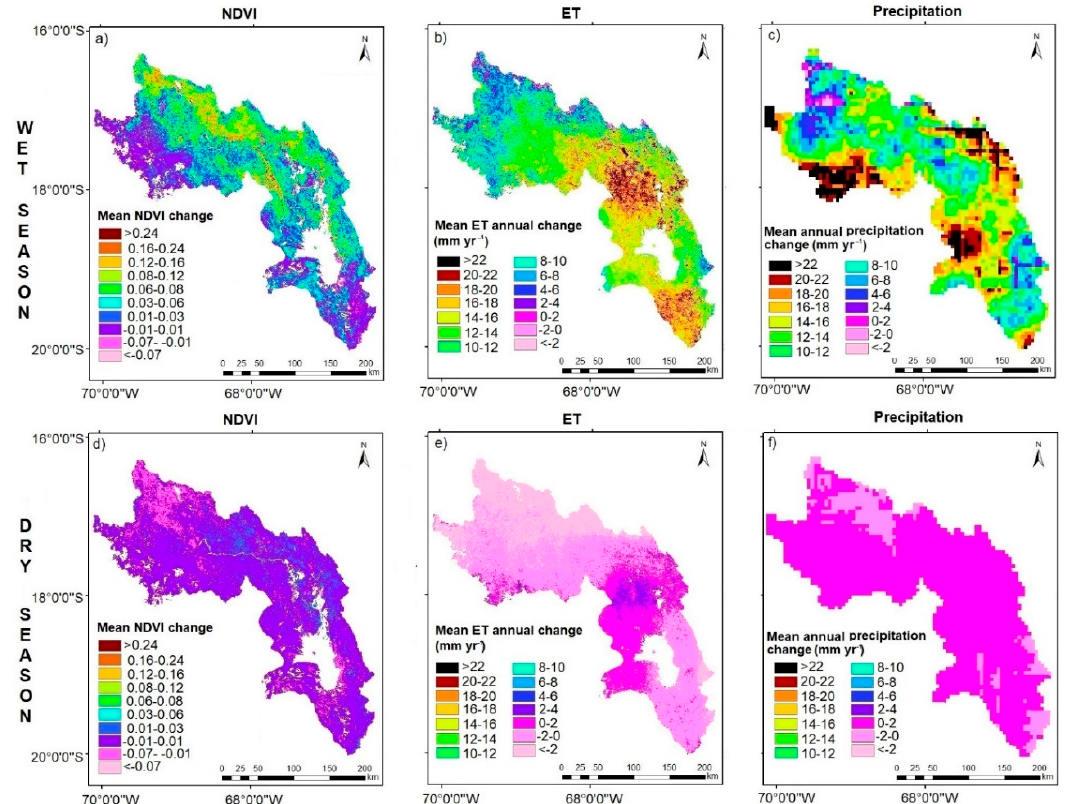
Figure 6. NDVI, ET and precipitation seasonal trends over the DP system for the period 2002–2014: Mean NDVI change (calculated as the mean trend multiplied by the duration of the study period) for ( a ) wet season and ( d ) dry season; ET mean annual change for ( b ) wet season and ( e ) dry season; and precipitation mean annual change for ( c ) wet season and ( f ) dry season. Table 2. Regional annual ET mean changes in the DP System from 2002 to 2014. NDVI mean change for the study period 2002–2014. Statistics obtained from the non-parametric Mann-Kendall test. Wet period Dry period